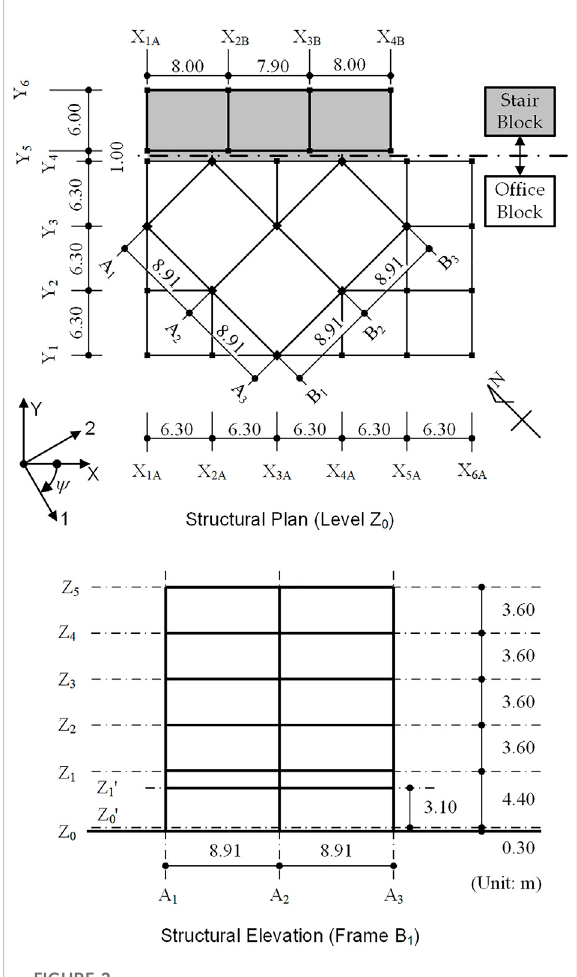
FIGURE 2 Simpli fi edstructuralplan andelevationoftheformerUto City Hall (Fujii,